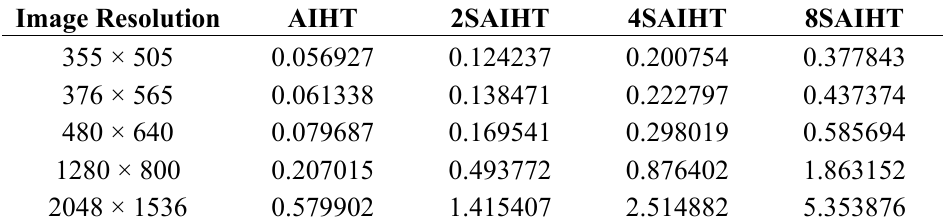
Table 1. Comparison of run-time results of various scales of Multi-Scale AIHT (MSAIHT). Image Resolution AIHT 2SAIHT